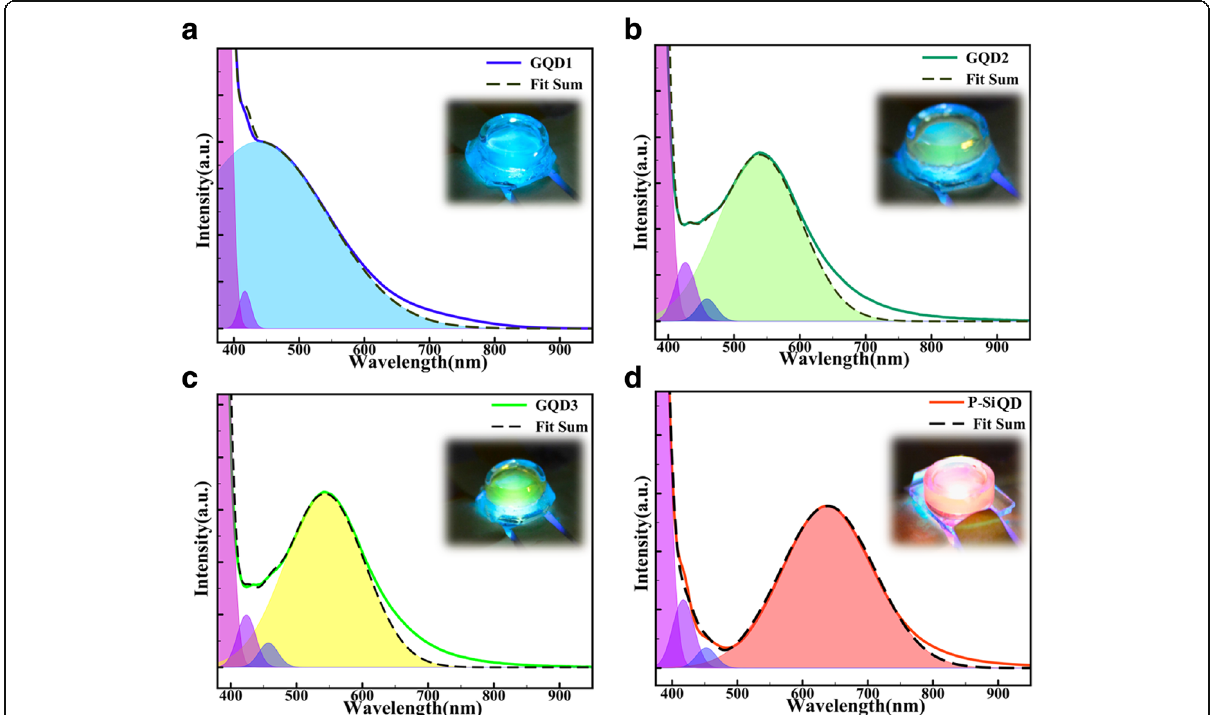
Fig. 3 Spectra of the liquid-type monochrome QD LED package for a GQD1, b GQD2, c GQD3, and d P-Si QD at a current of 60